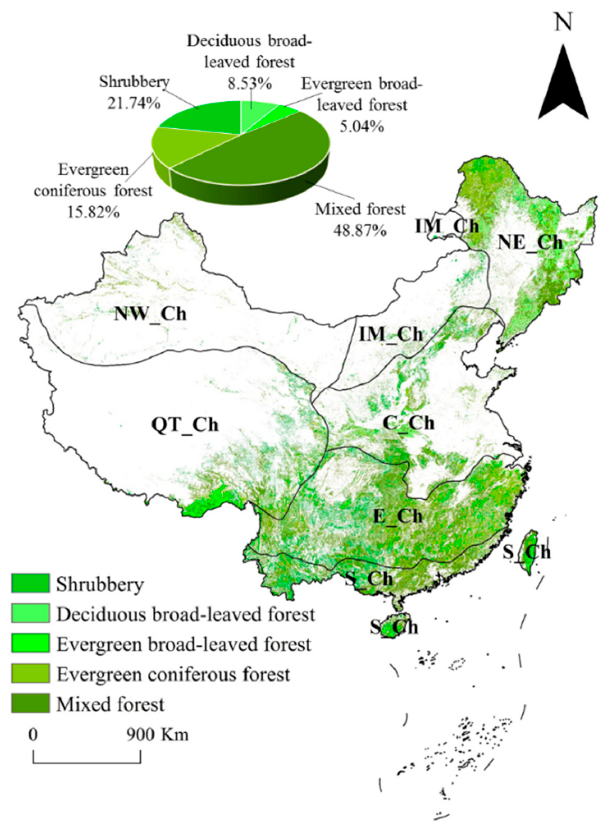
Figure 1. Spatial distribution and proportional area of forest ecosystems in China, 2015. The acronyms are Northeast China (NE_Ch), Inner Mongolia (IM_Ch), Northwest China (NW_Ch), Qinghai-Tibet (QT_Ch), Central China (C_Ch), East China (E_Ch), South China (S_Ch), and China, respectively.